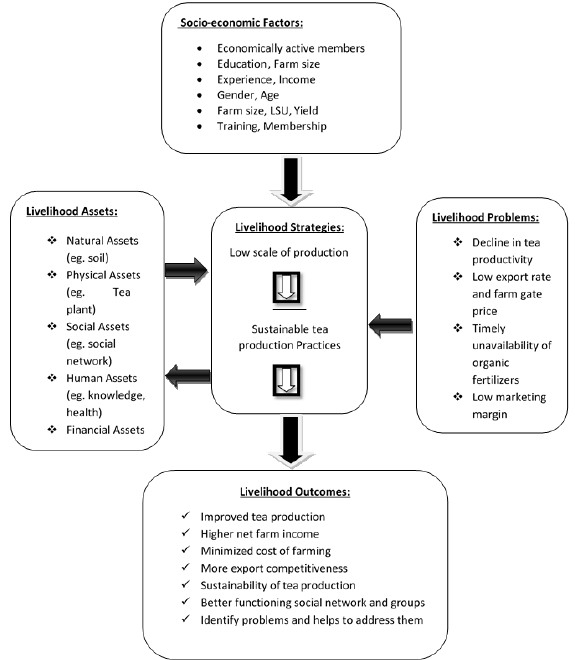
Figure 1: The conceptual framework of the study